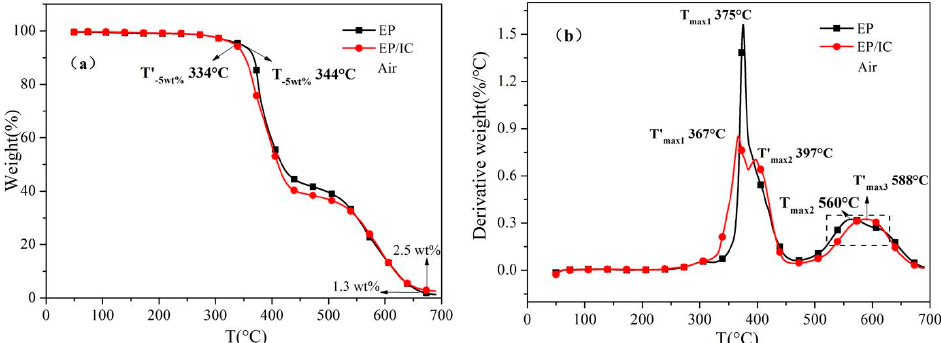
Figure 7. ( a ) TGA and ( b ) DTG curves of EP and EP/IC under air.